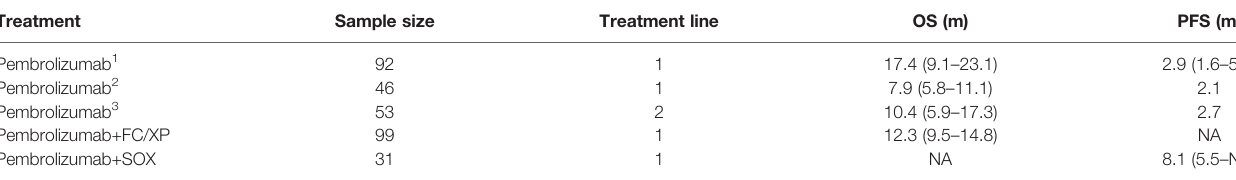
TABLE 4 | Results of immunotherapy in patients with PD-L1 CPS ≥